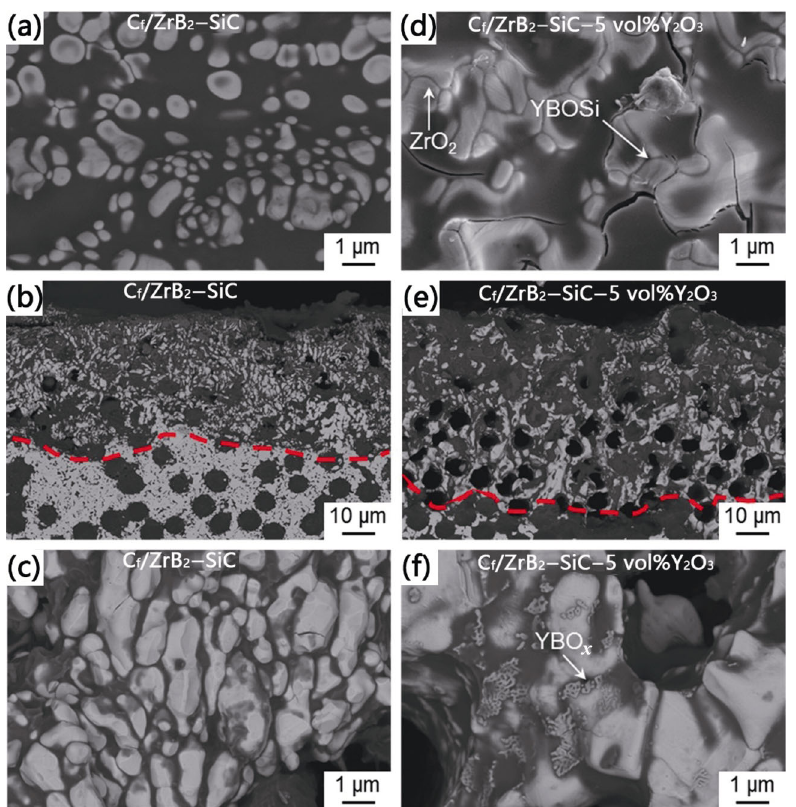
Fig. 26 Microstructures of C f /ZrB 2 –SiC and C f /ZrB 2 –SiC–5 vol%Y 2 O 3 composites after oxidation at 1650 in air: surface ℃ morphology (a, d), cross-sections of the oxide layer (b, e), and detail of the oxide layer (c, f). Reproduced with permission from Ref. [276], © Elsevier Ltd.